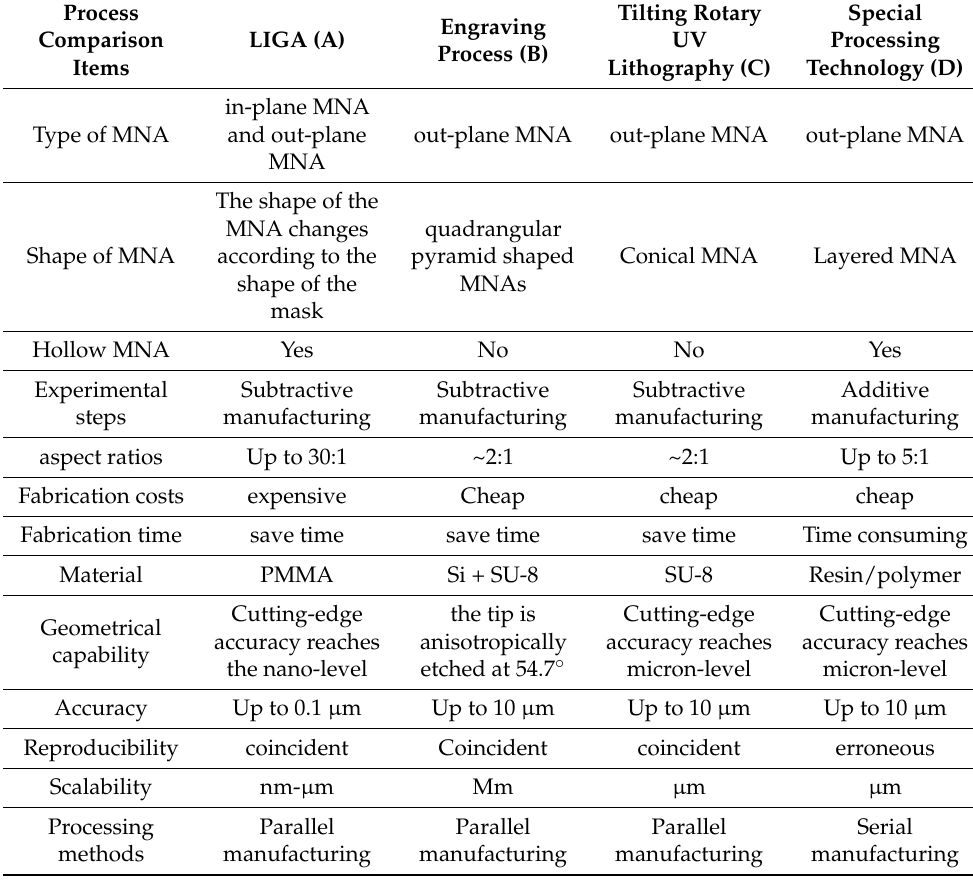
Table 1. Comparison of Three Processes and Special Processing